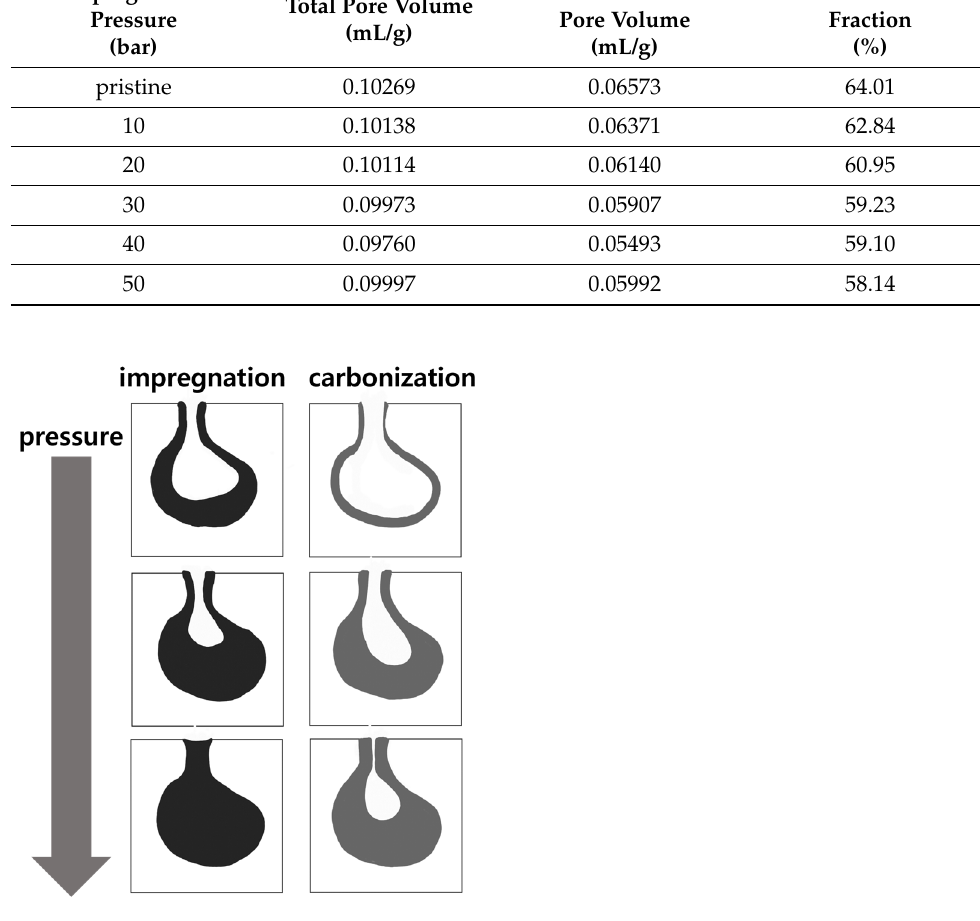
Table 3. Pore volumes and ink bottle fractions of the graphite blocks before and after impregnation.